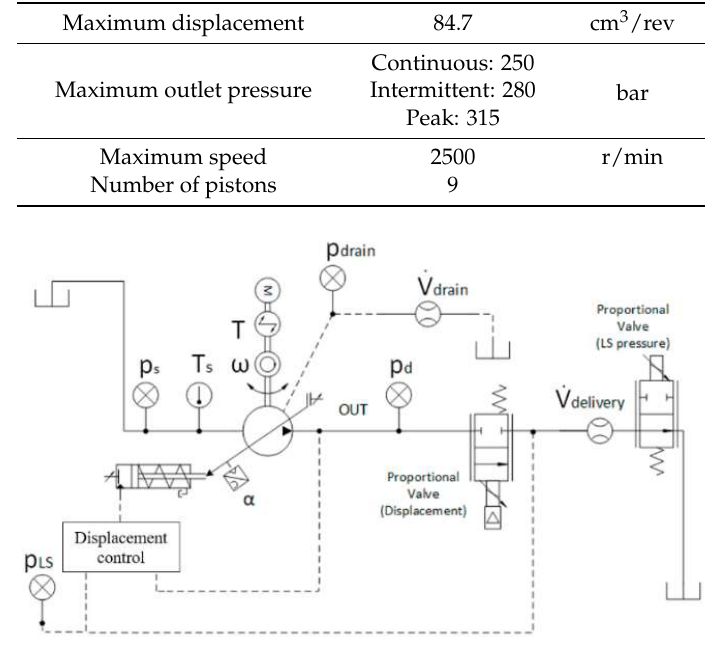
Table 1. Pump characteristics.